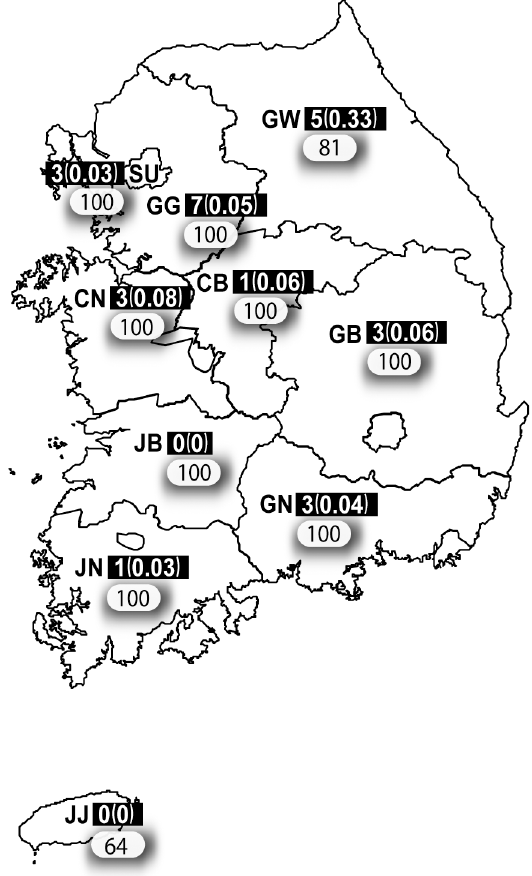
Fig 1. Study areas and distribution of study subjects. Human serum samples were obtained from the National Biobank of Korea. Using simple random sampling, 945 subjects were selected within four age groups from 10 provinces. The number of subjects per area is provided in the rounded rectangle. The number of patients with Japanese encephalitis in 2010 is provided in the black squares. In addition, the incidence rates per 100,000 persons in each province are provided in parenthesis. SU, Seoul; GG, Gyeonggi; CB, Chungbuk; CN, Chungnam; JB, Jeonbuk; JN, Jeonnam; GN, Gyeongnam; GB, Gyeongbuk; GW, Gangwon; JJ,